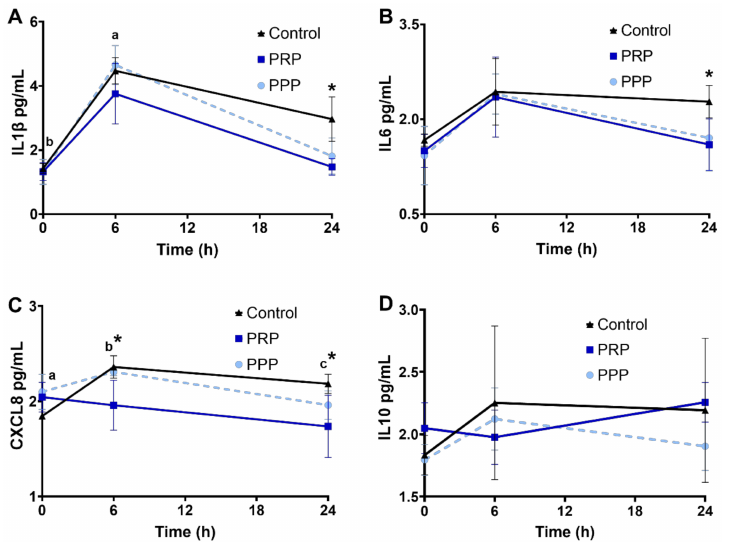
Figure 4. Concentrations (log10) of cytokines (( A ), IL1 β ; ( B ), IL6; ( C ), CXCL8; ( D ), IL10), in uterine fluid of mares susceptible to persistent breeding induced endometritis. Assessments were carried out from pre- (0 h, early onset of estrus), 6, and 24 h post-breeding. Mares ( n = 6) had estrous cycles ( n = 18) assigned to receive four intrauterine infusions with Lactate Ringer’s Solution (Control, n = 6), platelet-rich (PRP n = 6), or -poor plasma (PPP n = 6) in a crossover design. Different superscripts denote the effects of time ( a,b,c ). Asterisk (*) denotes difference between control- and PRP-assigned cycles ( p < 0.05).